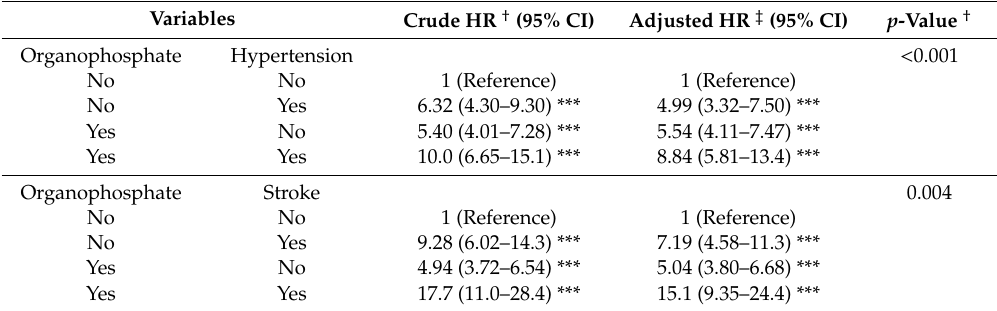
Table 3. Cox proportional hazard regression analysis of the risk of seizures associated with the interactions of organophosphate poisoning and